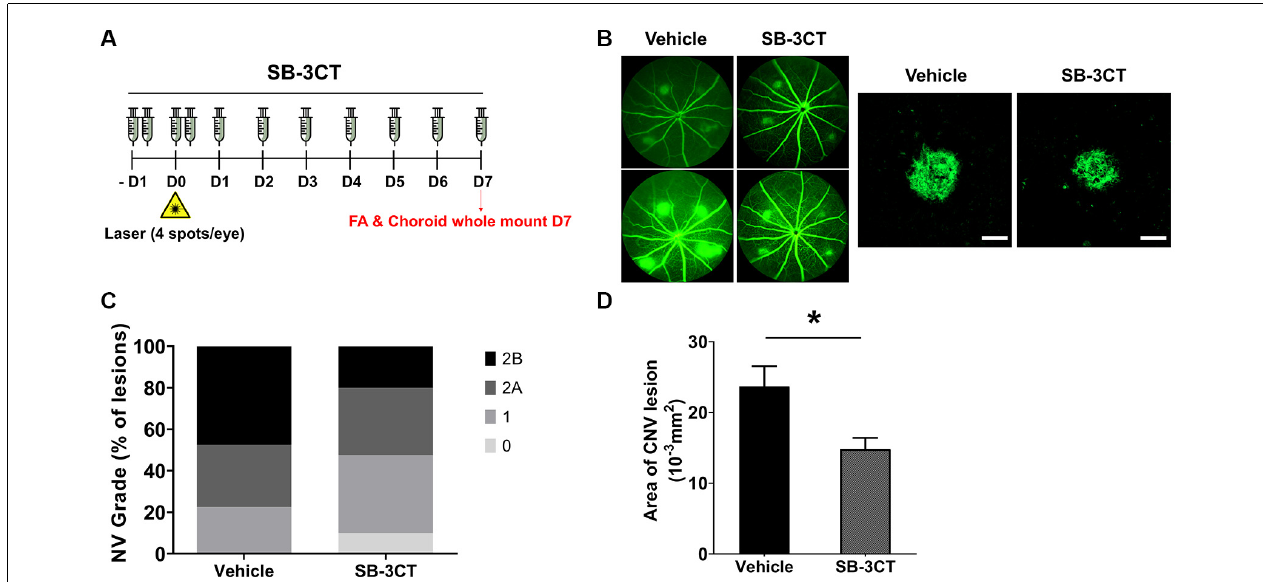
FIGURE 5 | Effect of SB-3CT on neovascular activity in the laser-induced CNV. (A) Experimental design of the SB-3CT injection and CNV induction with laser photocoagulation. (B) At 7 days after CNV induction, CNV lesion grading was conducted in control and SB-3CT groups. (C) The proportion of grade 2B lesions, which exhibit clinically significant leakage, decreased in mice treated with SB-3CT relative to the vehicle. (D) CNV lesion size decreased in mice treated with SB-3CT compared with vehicle, as assessed in choroidal flat mounts stained with fluorescent isolectin B4. * P < 0.05. n = 48 lesions/group. Scale bar: 100 µ